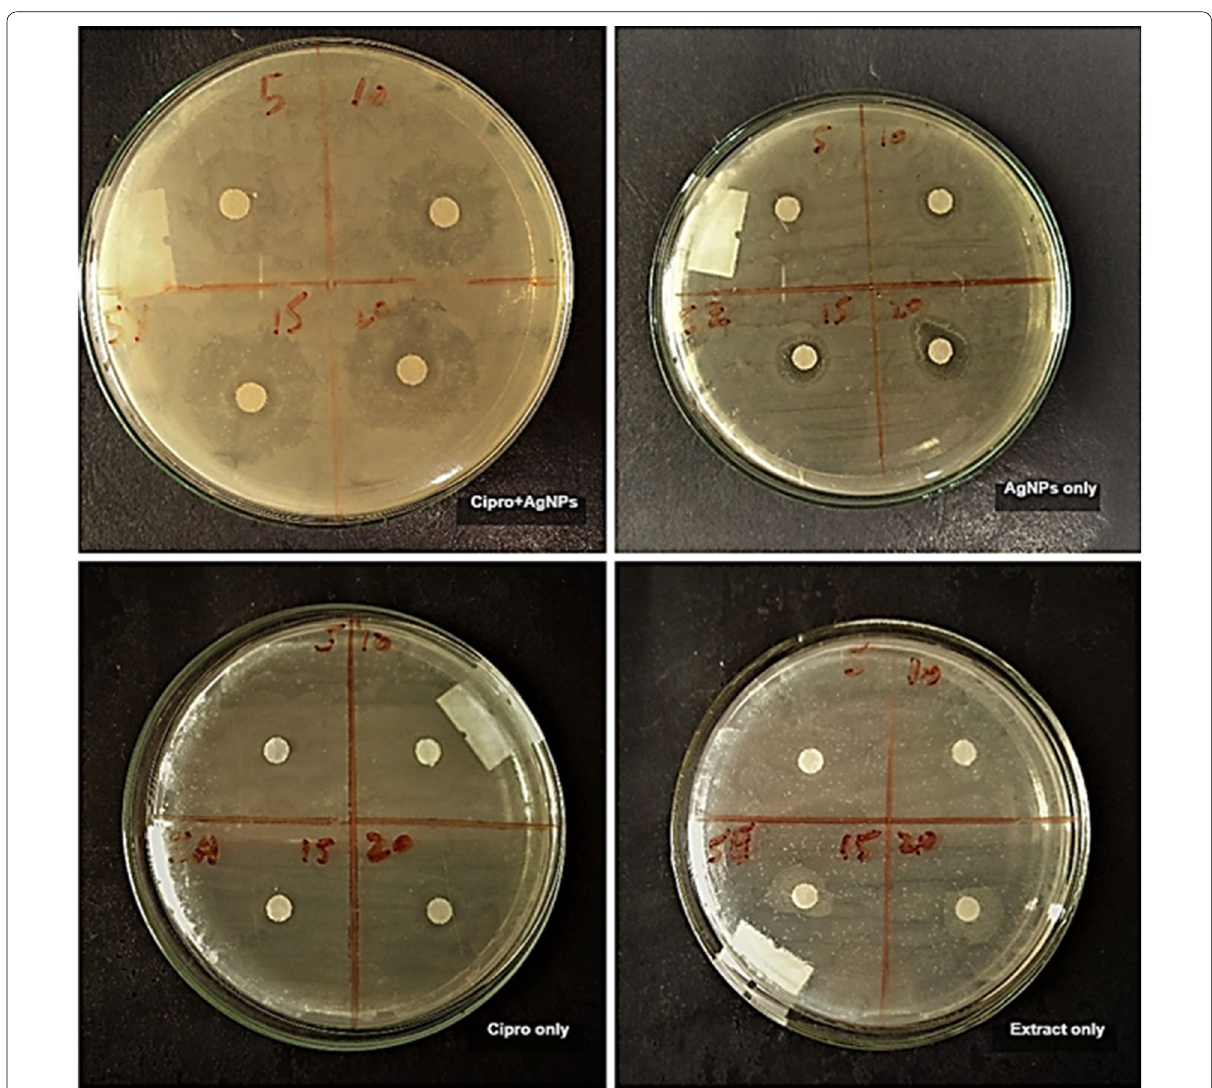
Fig. 5 Activity of ciprofloxacin callus extract mediated AgNPs, callus extract mediated AgNPs, ciprofloxacin only and extract only controls against + Citrobacter